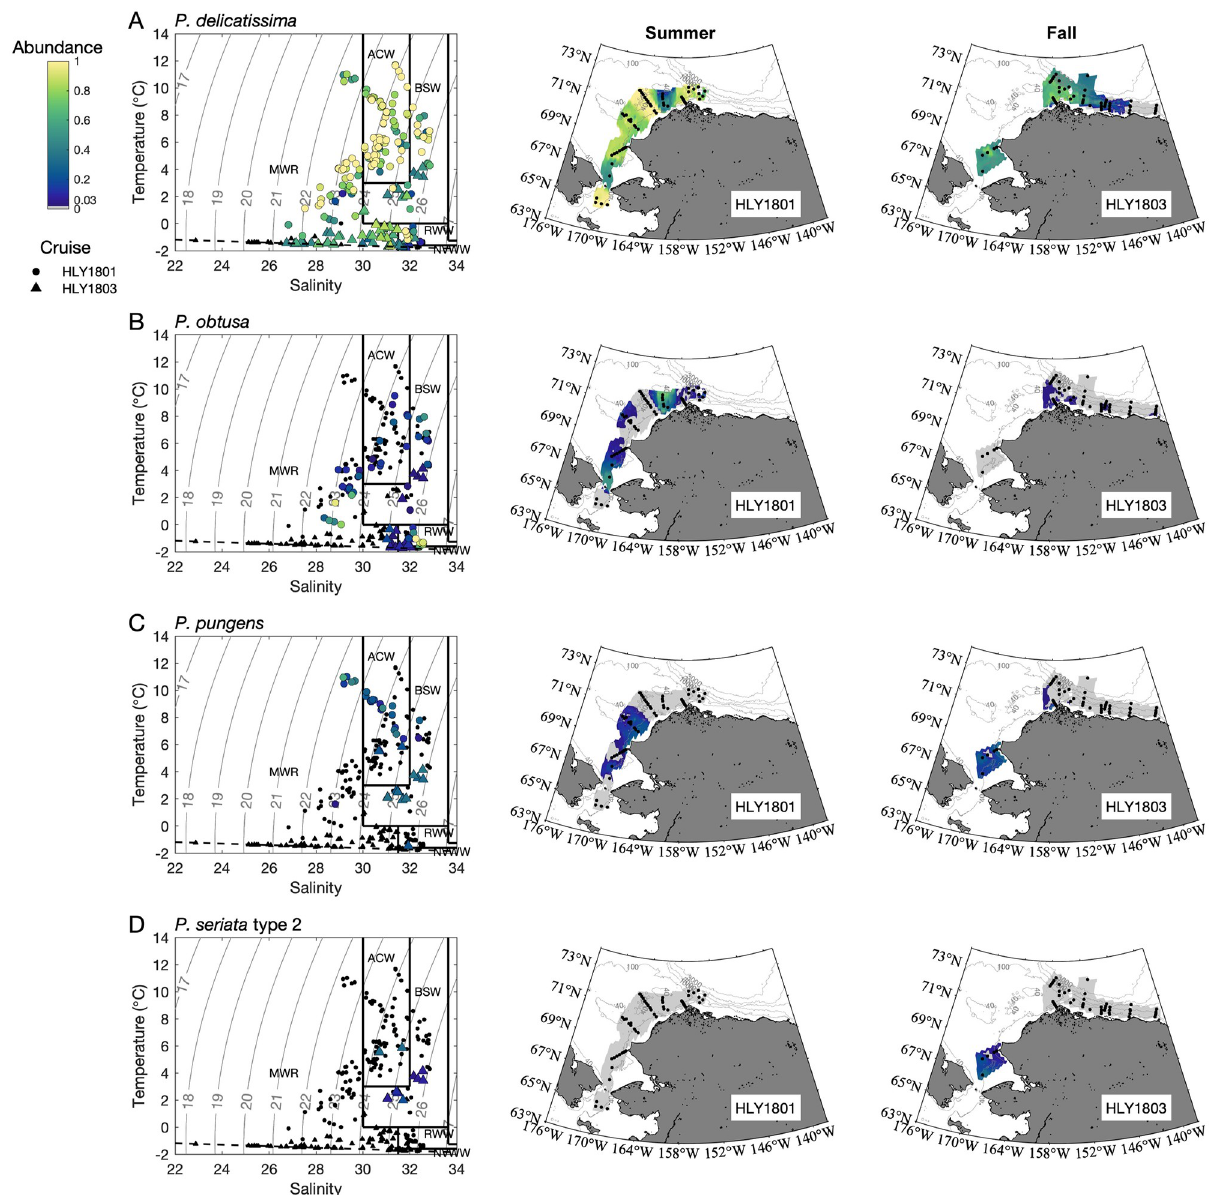
Fig 3. Distribution of species generally more prevalent in warmer water masses. Relative abundance of A) P . delicatissima , B) P . obtusa , C) P . pungens , and D) P . seriata “type 2” plotted in temperature and salinity space for all collection depths (left panels; solid lines show water mass boundaries, dotted lines show potential density, and dashed lines show freezing point of seawater) and plotted as contour plots for 10 m depth for summer ( Healy 1801; middle panels) and fall ( Healy 1803; right panels). Stations sampled during the respective cruises are indicated by black circles on the maps. Water mass abbreviations are the same as in Table 2.